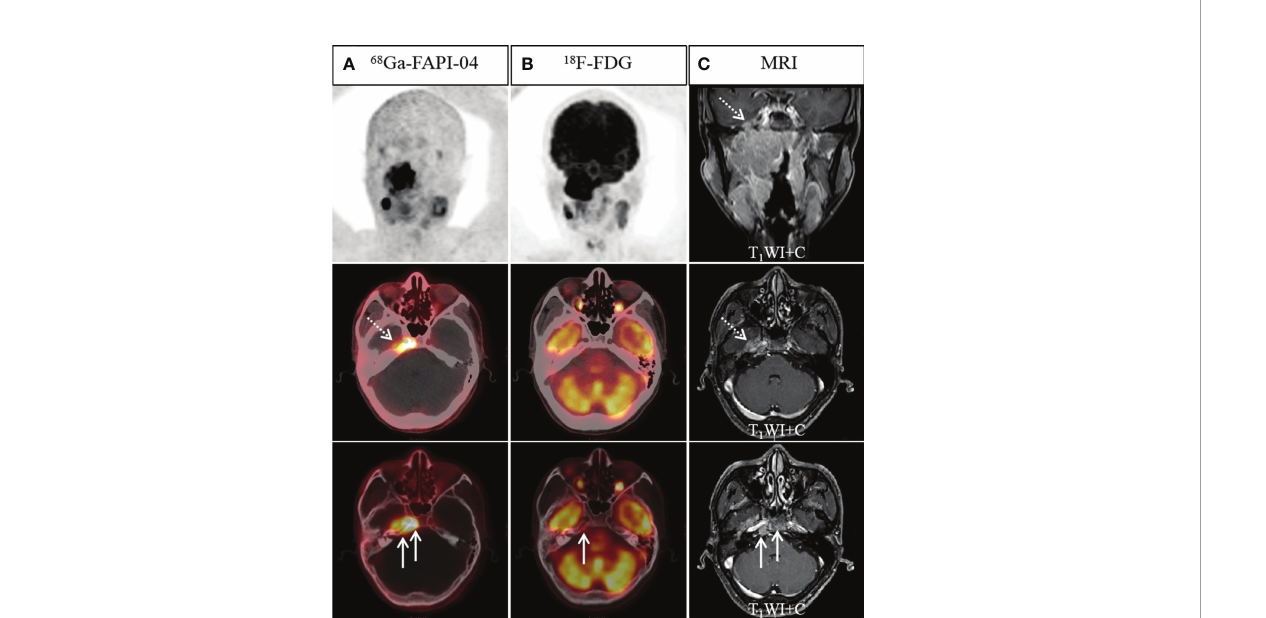
FIGURE 2 A 45-year-old man with nonkeratinizing differentiated carcinoma. Intense 68 Ga-FAPI-04 uptake was observed in the left temporal lobe ( A , dotted arrow), suggesting intracranial invasion, but 18 F-FDG PET/CT (B) showed no abnormal intracranial 18 F-FDG uptake. Moreover, intense 68 Ga-FAPI-04 uptake was observed in the occipital and right temporal bone ( A , solid arrow), while 18 F-FDG PET/CT only showed low tracer uptake in the right temporal bone ( B , solid arrow), which was con fi rmed by MRI ( C , solid arrow). 68 Ga-FAPI-04 PET/CT revealed more extensive lesions on intracranial and skull base invasion than 18 F-FDG